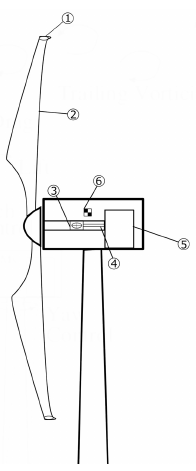
Figure 2. Model used during tests: 1—bolts mounting; 2—propeller’s blade; 3—bearing; 4—clutch; 5—servomechanism; 6—marker for image processing.